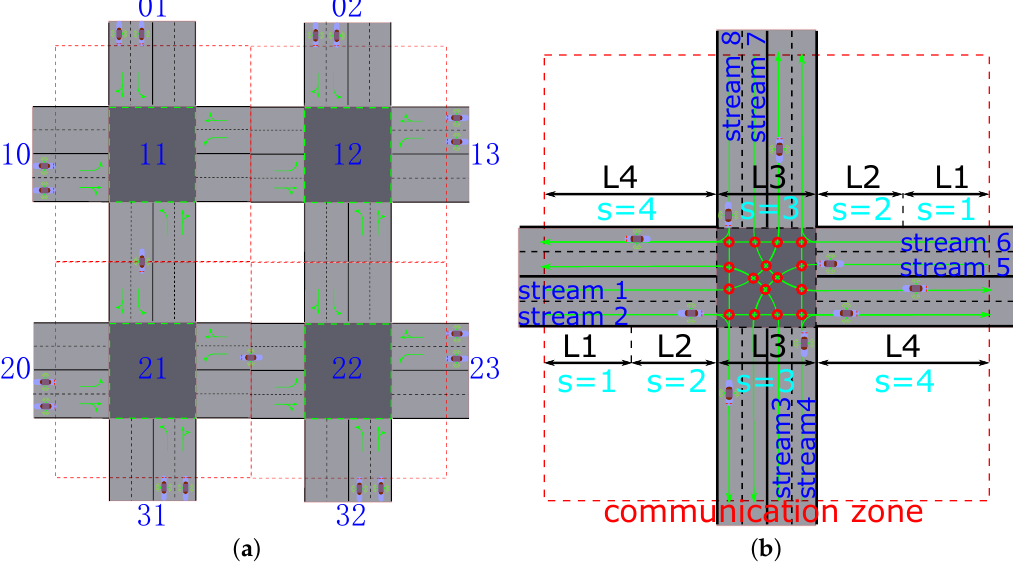
Figure 1. Proposed traffic model without traffic lights. ( a ) Network of intersections; ( b ) Isolated detailed intersection.